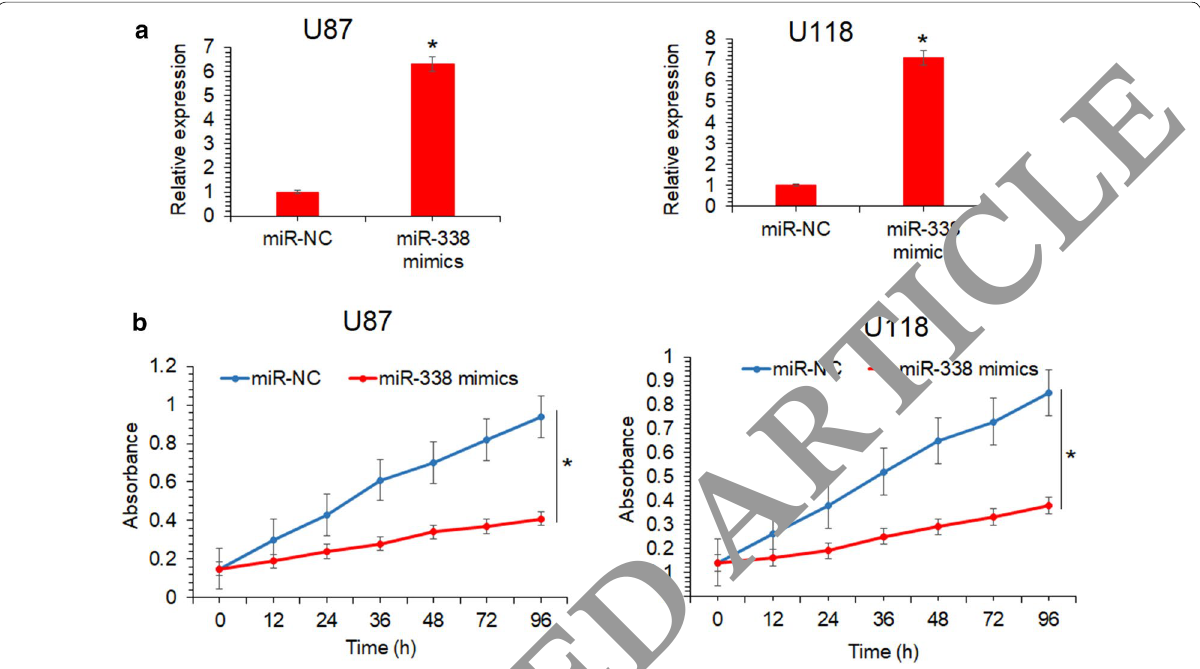
Fig. 7 The regulatory effects of lncRNA-LINC00525 are exerted though miR-338-3p in human glioma. a Expression analysis of miR-338-3p from U87 and U118 cancer cells transfected with miR-NC or miR-338 mimics, b expression analysis of lncRNA-LINC00525 from U87 and U118 cancer cells transfected with miR-NC or miR-338 mimics, c the estimation of proliferation of U87 and U118 cancer cells transfected with miR-NC or miR-338 mimics by MTT assay. The experiments were performed in triplicate and expressed as mean